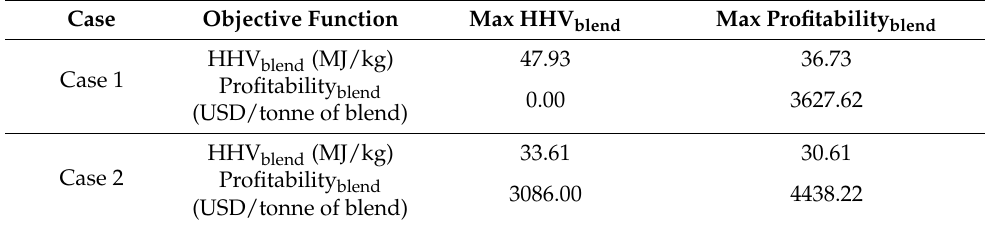
Table 6. Results from single objective optimisation of HHV and profitability of solvent-oil blend.